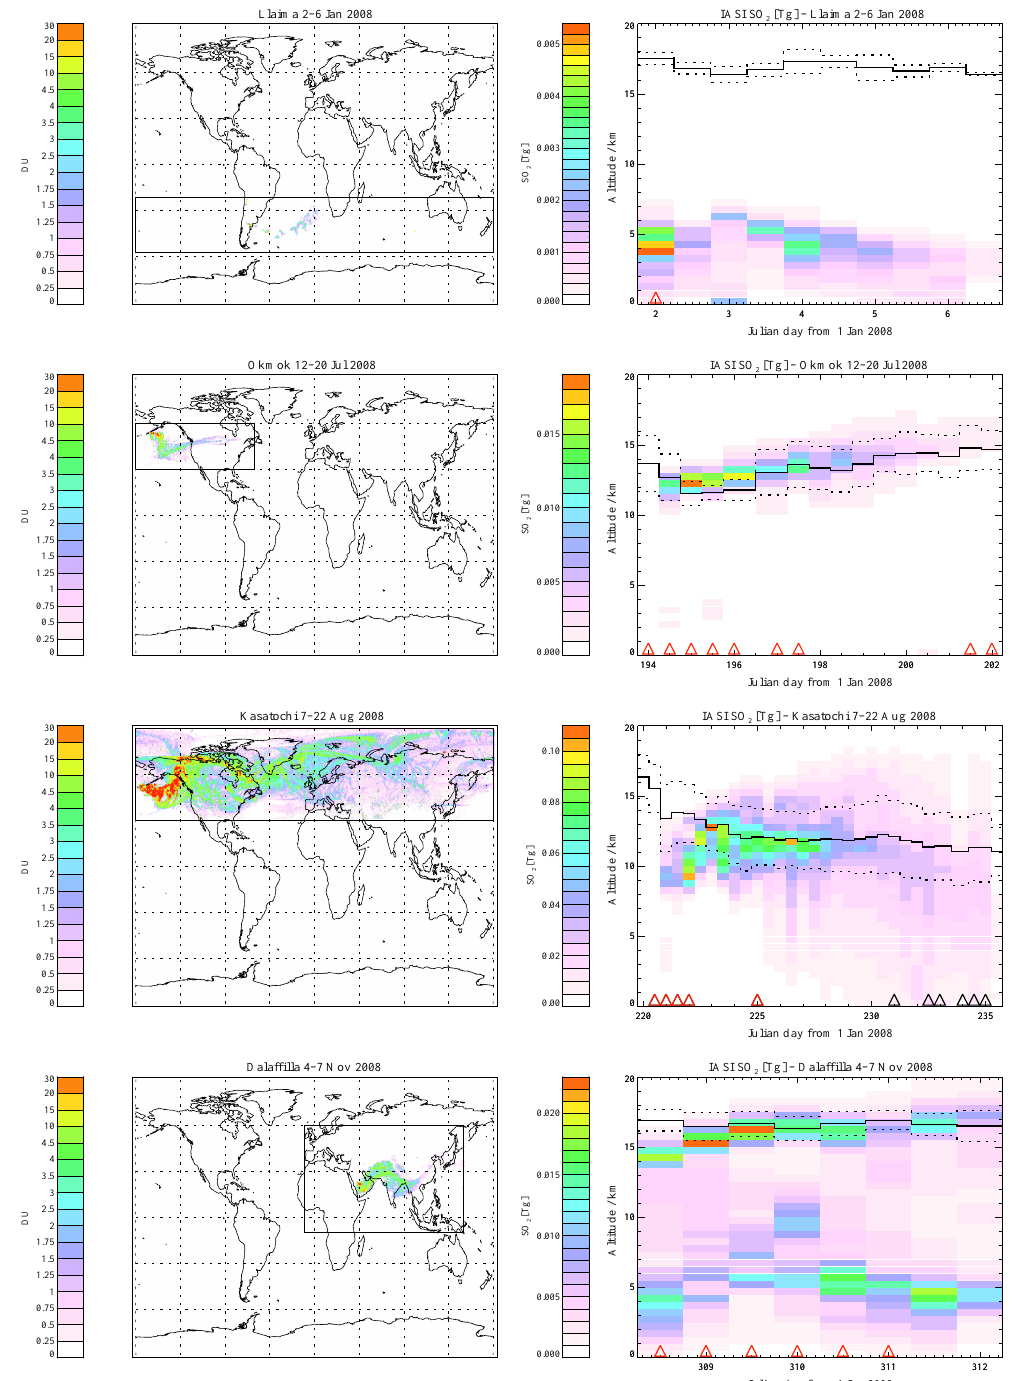
Figure 8. The left column shows maps of the maximum SO 2 amount retrieved within the considered area (black rectangle). The right column shows the SO 2 vertical distribution for the considered volcanic eruption. In each plot the y axes are the vertical levels in km. The colour represents the total mass of SO 2 in Tg, dark-red represents values higher than the colour-bar. Every column of the plots come from an IASI map (one every 12h). The black lines are the mean, and the mean plus or minus the standard deviations, of tropopause computed from ECMWF profiles at the location of plume pixels. Red triangles in the bottom line indicate the presence of a fresh plume connected with the volcano, black triangles indicate the presence of an old plume overpassing the volcano (this may eventually mask a newer plume). Note that the plots for different eruptions have different colour-scales and cover different time